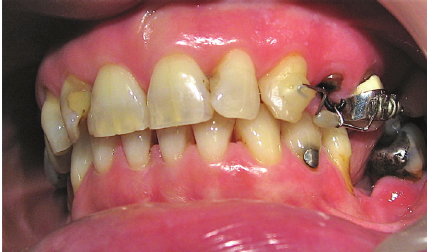
Figure 4: Final stages of extrusion and stabilization by a ligature.